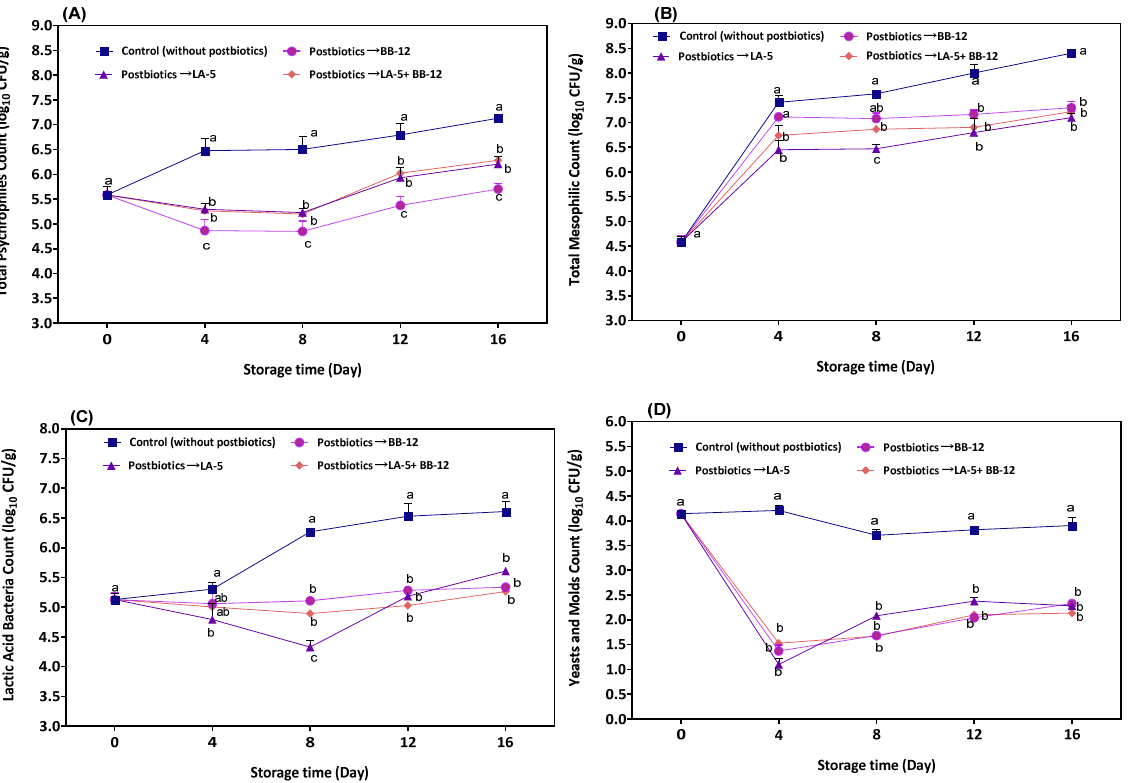
Figure 1. Changes in A: psychrophiles ( A ), mesophiles ( B ), lactic acid bacteria ( C ) and yeast and mold ( D ) population in mozzarella cheeses preserved in postbiotic solutions from L. acidophilus LA-5 (P-LA-5), B. animalis BB-12 (P-BB-12), and their combination during storage at 7 °C. Different lowercase letters indicate a significant ( p < 0.05) difference between treatments on each storage day.